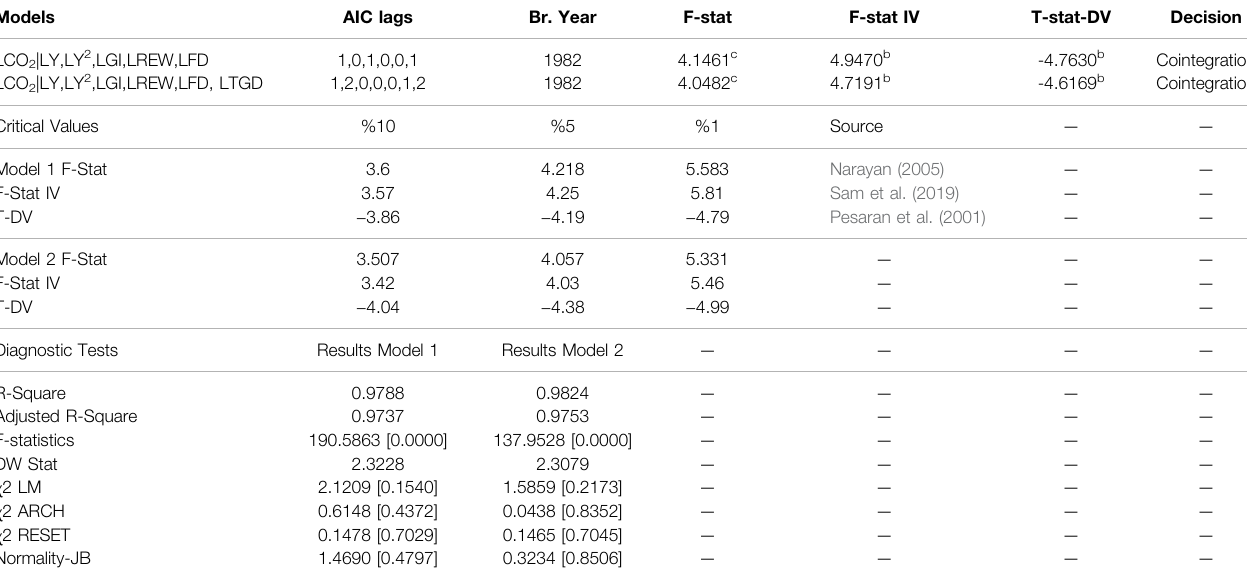
TABLE 4 | Cointegration analysis augmented ARDL test. Models